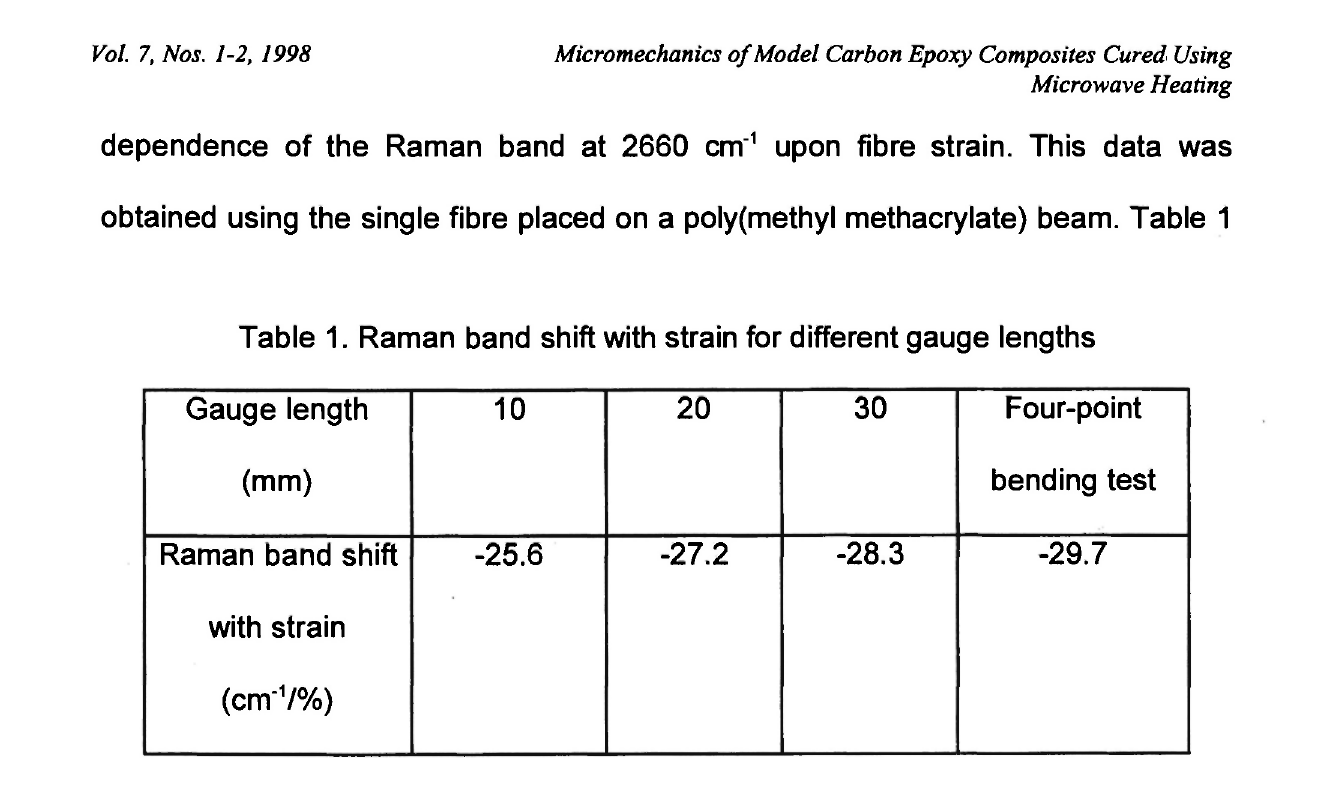
Table 1. Raman band shift with strain for different gauge